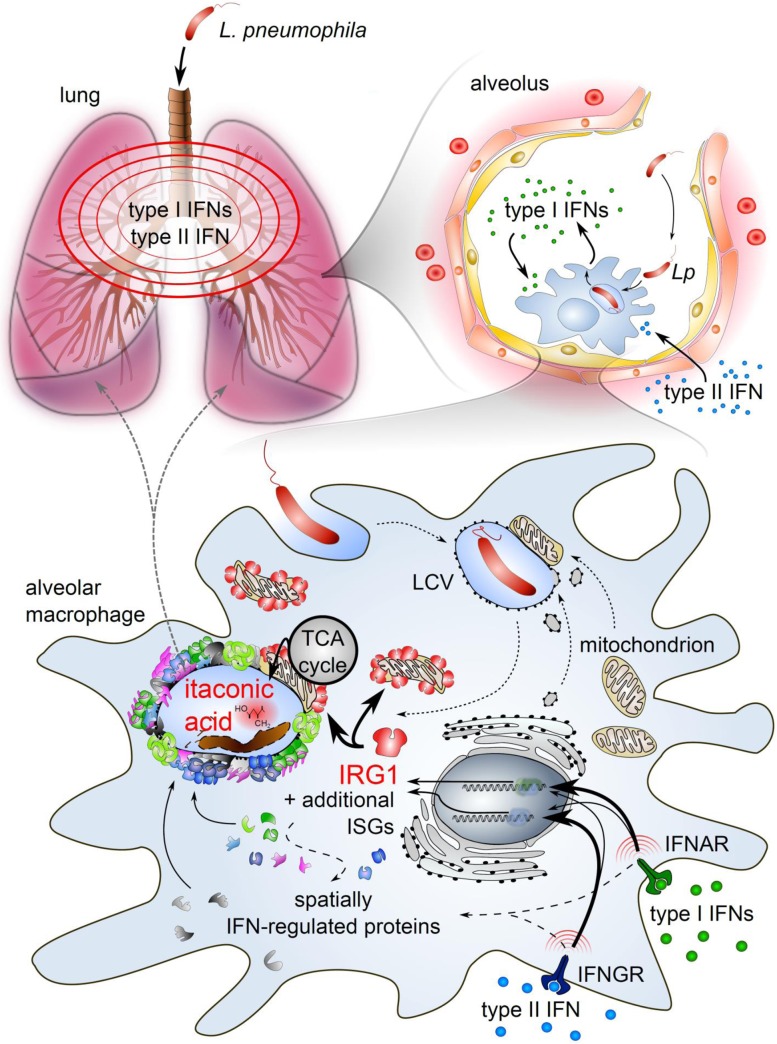
Overview of the type I and II IFN-driven, alveolar macrophage-intrinsic defense pathway that restricts L. pneumophila during lung infection (as discussed in the text).